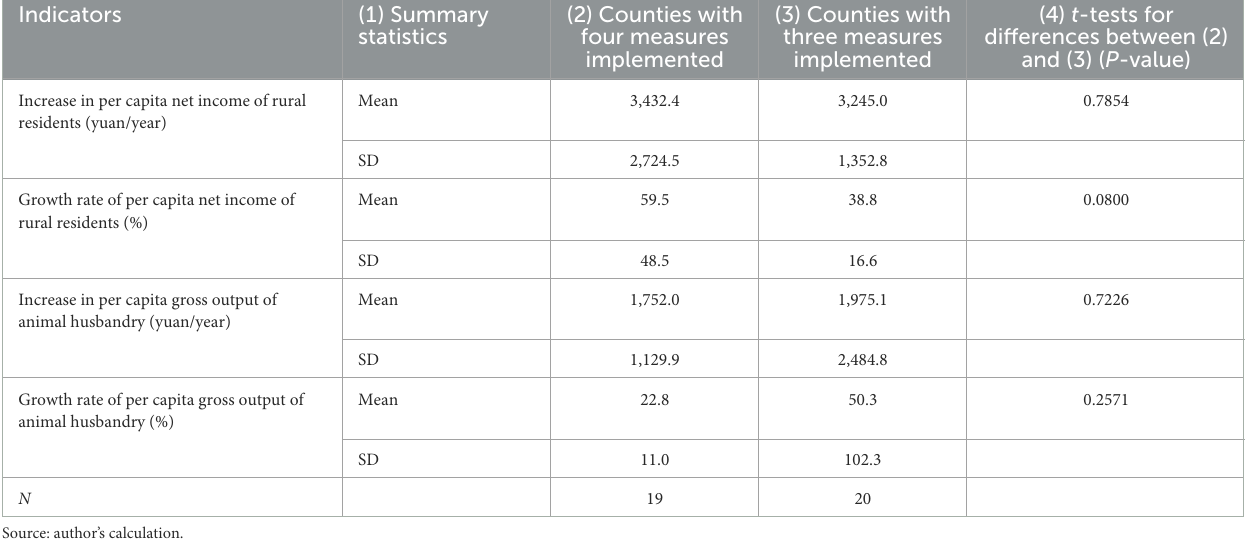
TABLE 3 Changes and growth rates of economic indicators for four- and three-measure counties from 2015 to 2020. Indicators